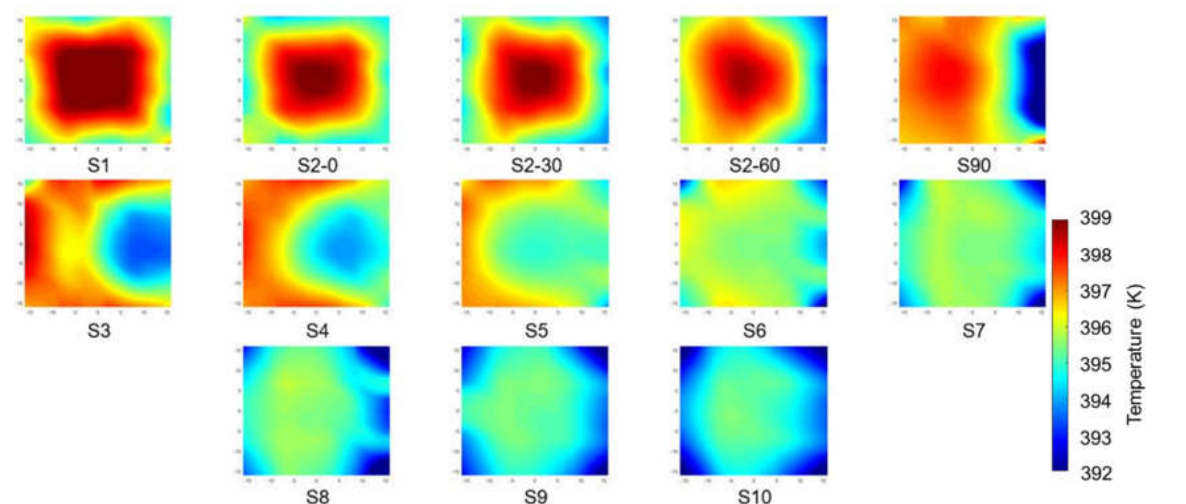
Figure 11. Temperature contours of different cross-sections of the “SC”.